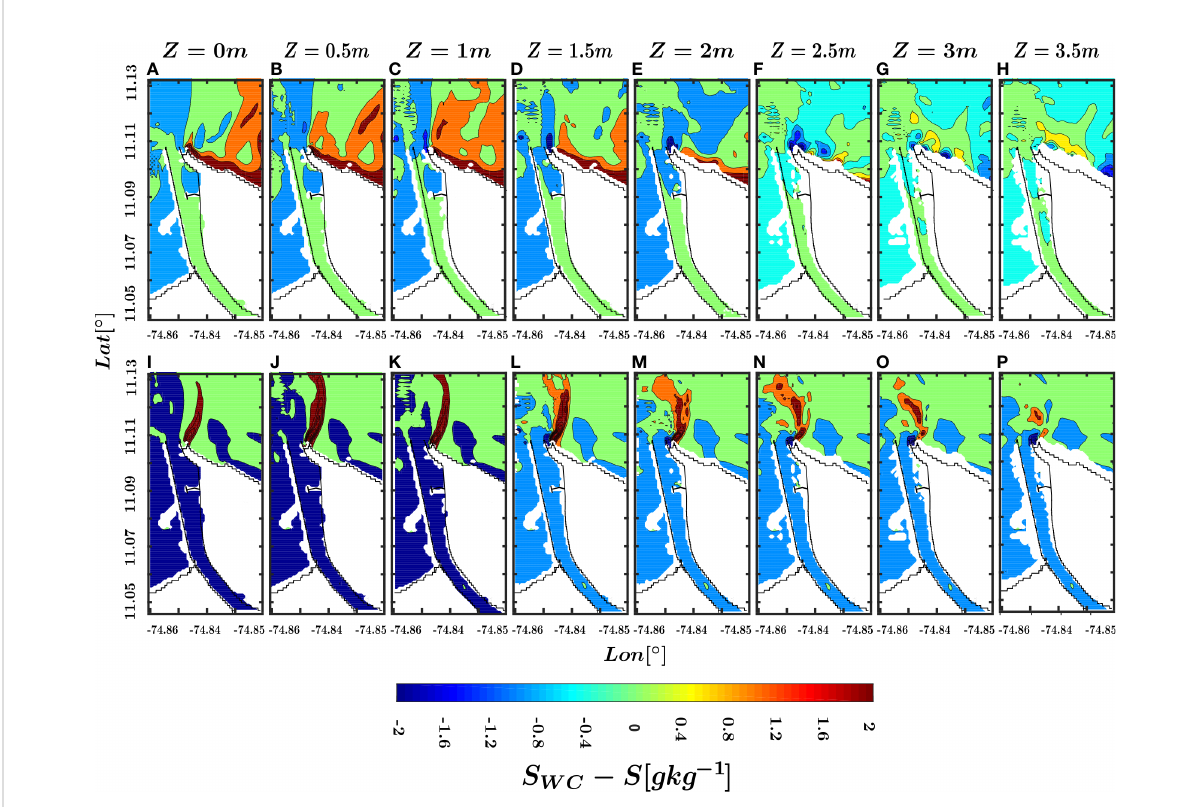
FIGURE 12 Difference in salinity distribution, with and without waves, for the dry seasons 2018 (upper panels) and 2020 (lower panels). Every 0.5m from the surface to 3.5 m